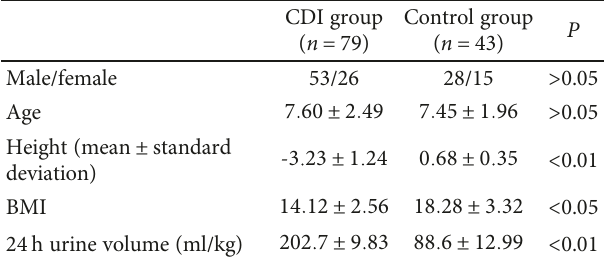
Table 3: Comparison between baseline data of CDI and control